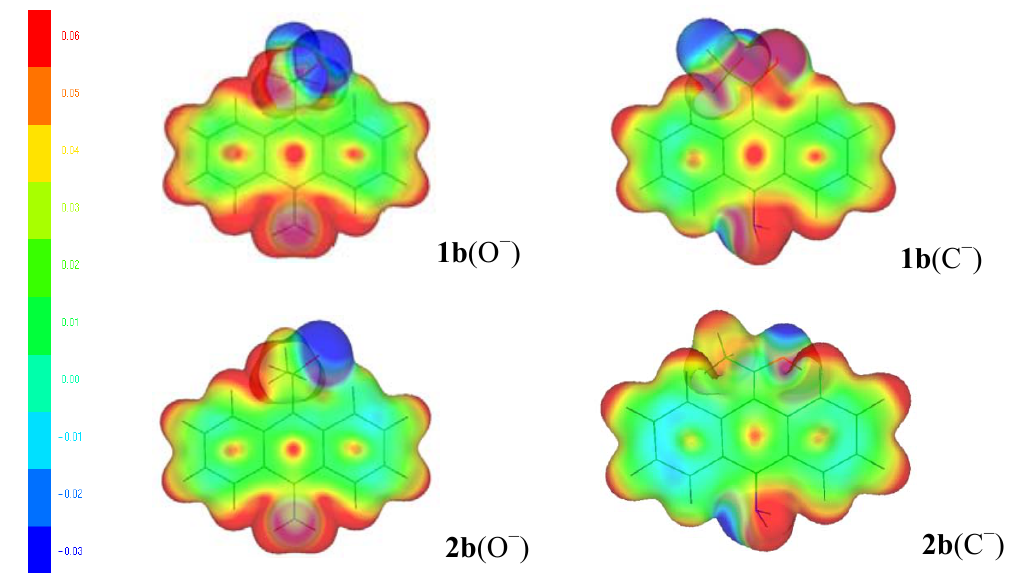
Figure 6. MEP mapped onto an isosurface of the total electron density for the alkoxides (O − ) and carbanions (C − ) of 1b and 2b .